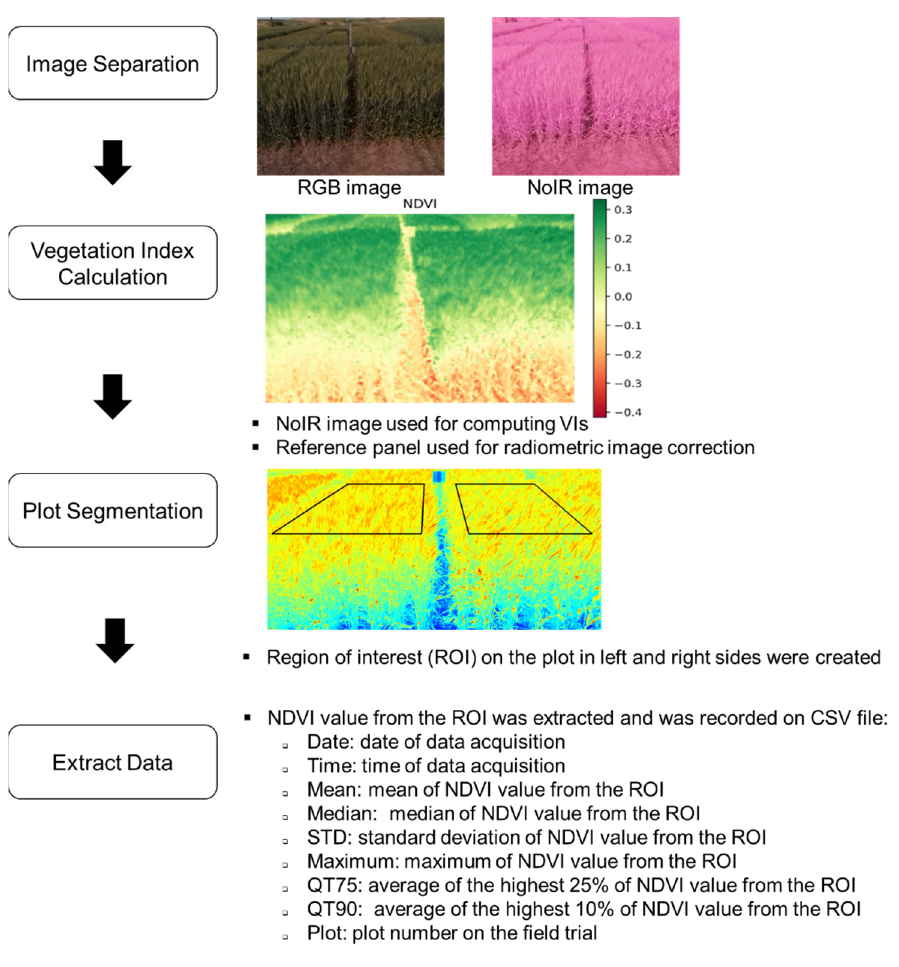
Figure 5. Image processing pipeline prior to extracting the vegetation index.